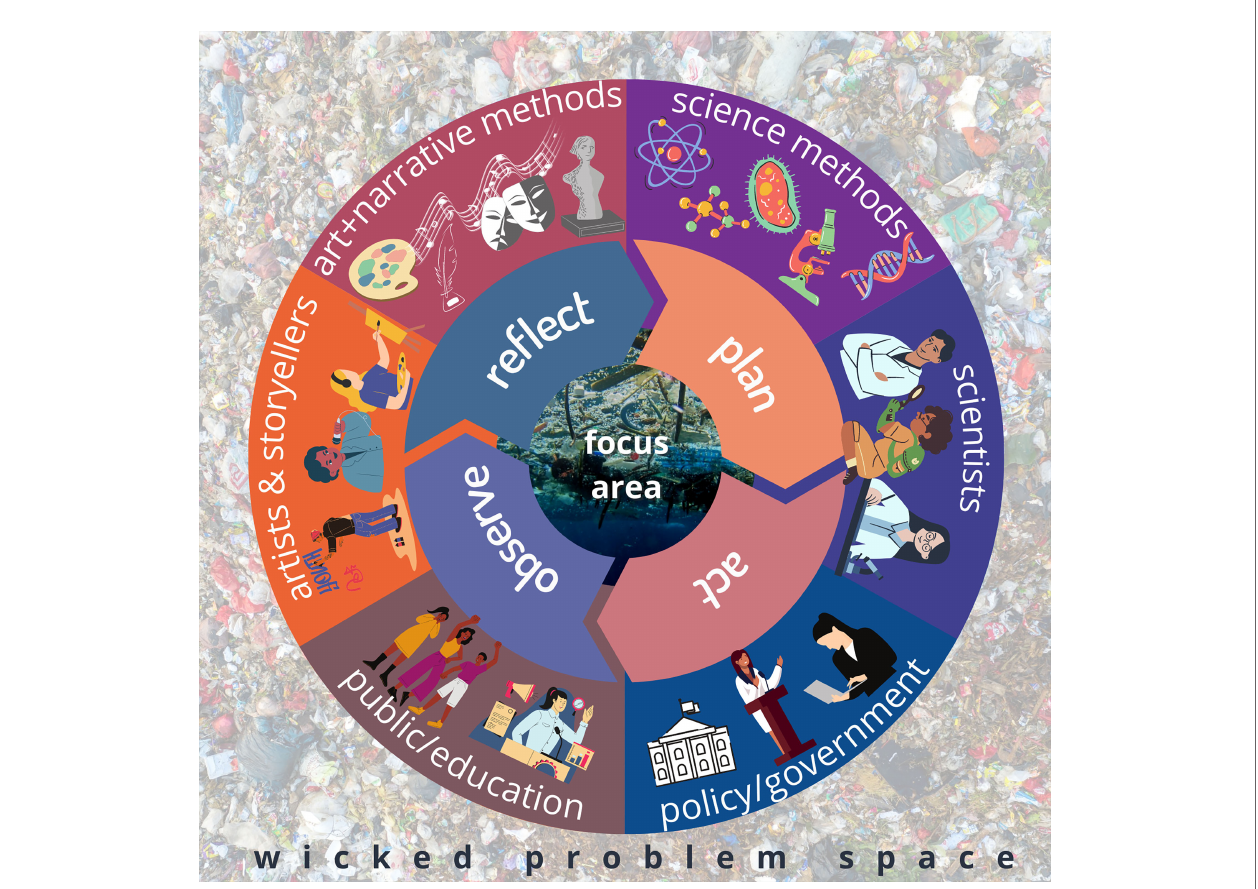
FIGURE 10 | Proposed process for ArtScience contributions to the challenges of the UN Decade through adaptive and iterative staged engagement process of artists, scientists and other stakeholders in public, education and government sectors as part of an ongoing mission-driven or place-based long-term inquiry. Artists, storytellers and scientists employ art, narrative and science methods to engage diverse audiences, bringing them into the circle of potential impact on a focus area within the larger wicked problem space. Iteratively cycling through stages of planning, action, observation and re fl ection on a focus area can lead to contextual insights, sense-making and relevant interventions. In this example the wicked problem space, represented by a background fi eld of trash, is the widely adopted linear extract-produce-consume-waste economic model, which has negatively impacted both human health and natural systems. The example focus area at the center of the diagram is the problem of marine plastic pollution (Created using free content from Canva.com,